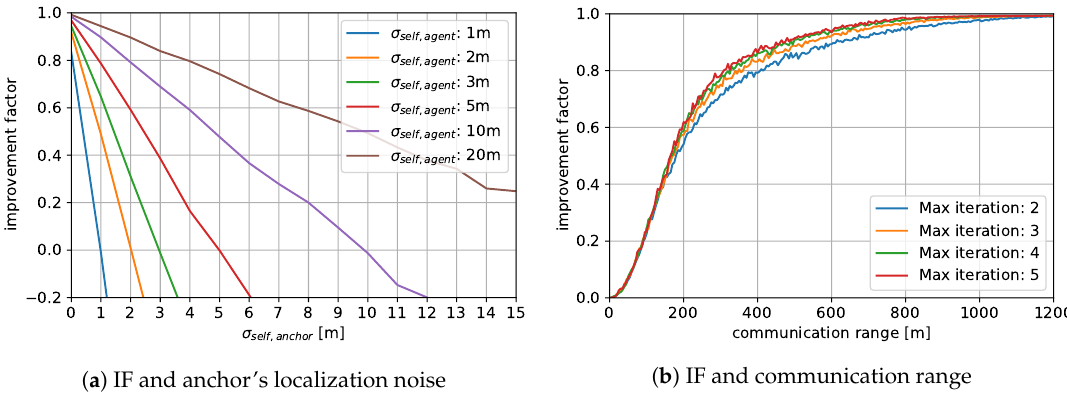
Figure 5. Changes of improvement factor (IF) of the proposed strategy under varying